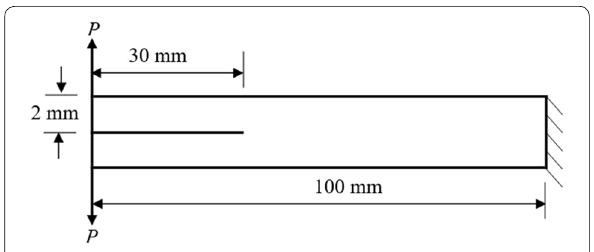
Fig. 3 Double cantilever beam along with initial crack and boundary